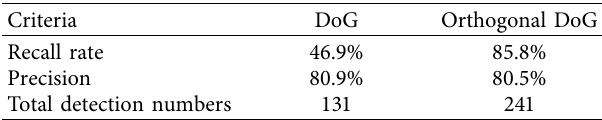
Figure 14: Final detection result and suspected short circuit areas with the improved orthogonal DoG filter and the DoG filter. (a) Orthogonal DoG. (b) DoG. Table 1: Statistical comparison of normal suspender detection between the improved orthogonal DoG filter and DoG